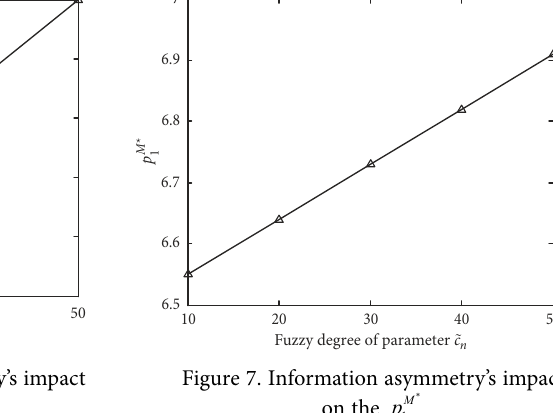
Figure 7. Information asymmetry’s impact on the